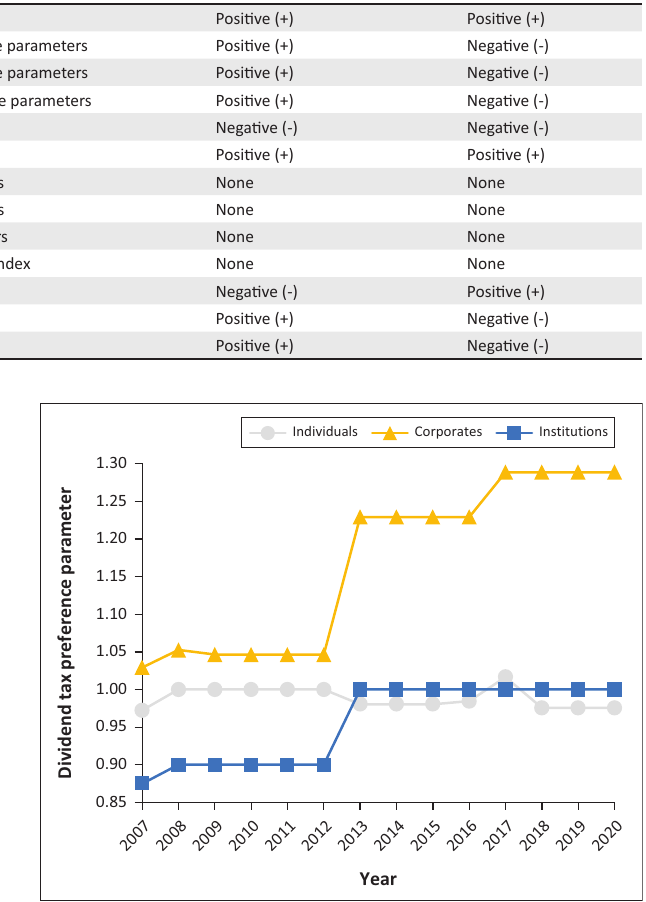
F IGURE 2: Dividend tax preference parameters per investor